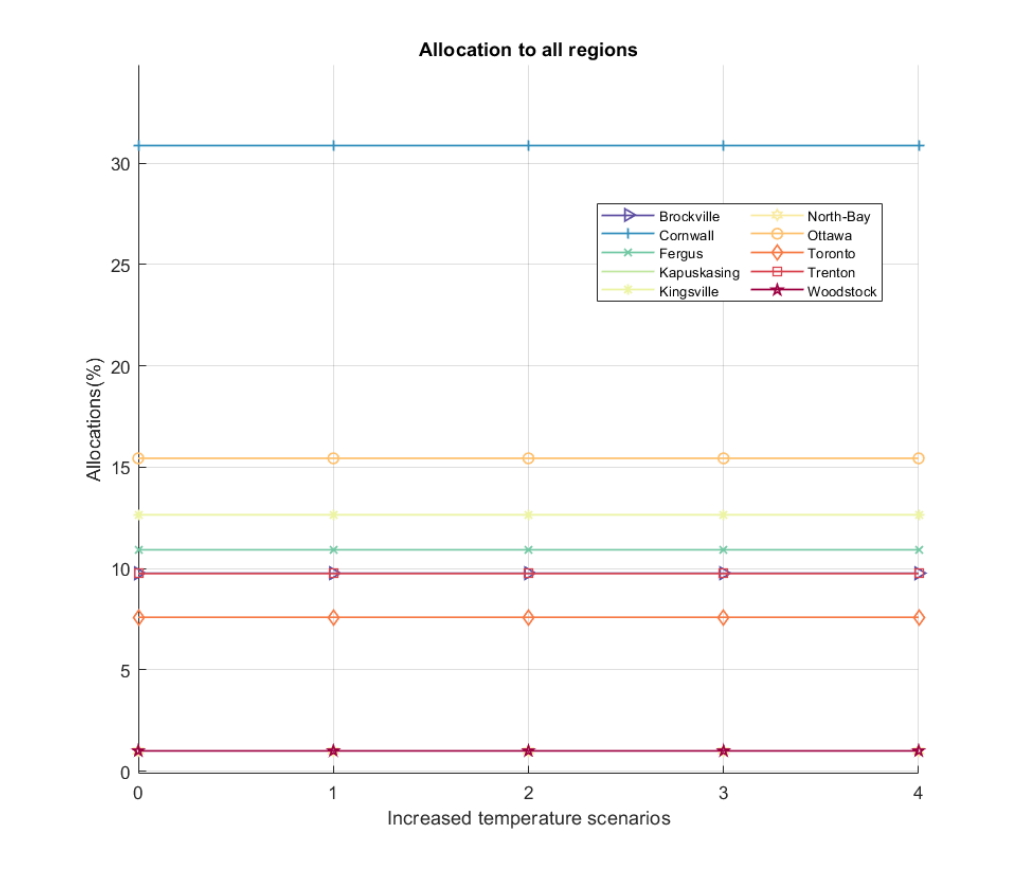
Figure 3. Allocations to each region under five different 1 ◦ C increased temperature